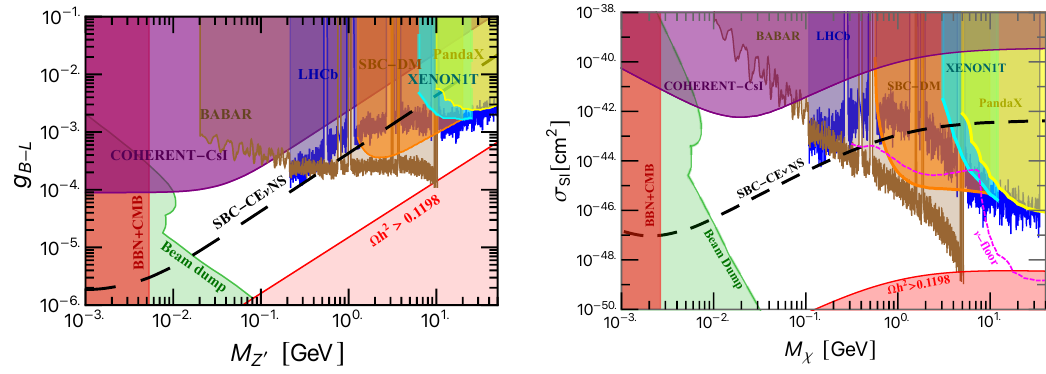
Figure 2 . Left panel: exclusion regions in the ( M Z 0 , g 0 ) plane for the B-L model. Right panel: exclusion regions for the spin independent cross-section in the ( M χ , σ SI ) plane for the B-L model. The light-purple shaded area corresponds to the constraint set by the current COHERENT-CsI data [1]. The limits set by the future reactor-based CE ν NS experiment SBC [43, 44], is presented using the black long dashed line (SBC-CE ν NS). The exclusion regions set by the BBN and CMB [70], beam dump experiments [71–81], BABAR [82] and LHCb dark photon searches [83] are presented using the red, light-green, light-brown and sky-blue regions, respectively. Limits set by the dark matter experiments are presented using the light-orange, light-cyan, and light-yellow regions for the SBC-DM [43], XENON1T [25], and PandaX-II [26] experiments, respectively (see text for more details). In the right panel, the argon ν -floor background [84] has been marked using dotted- magenta